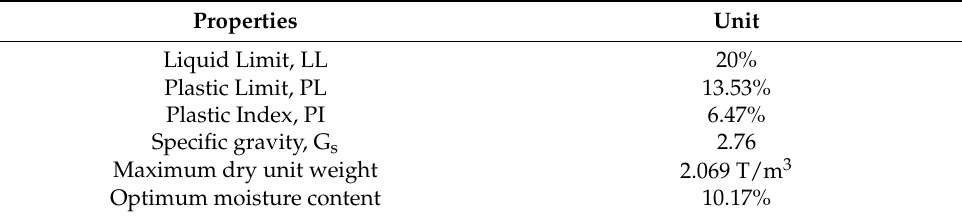
Table 3. Basic engineering properties of the laterite soil samples.